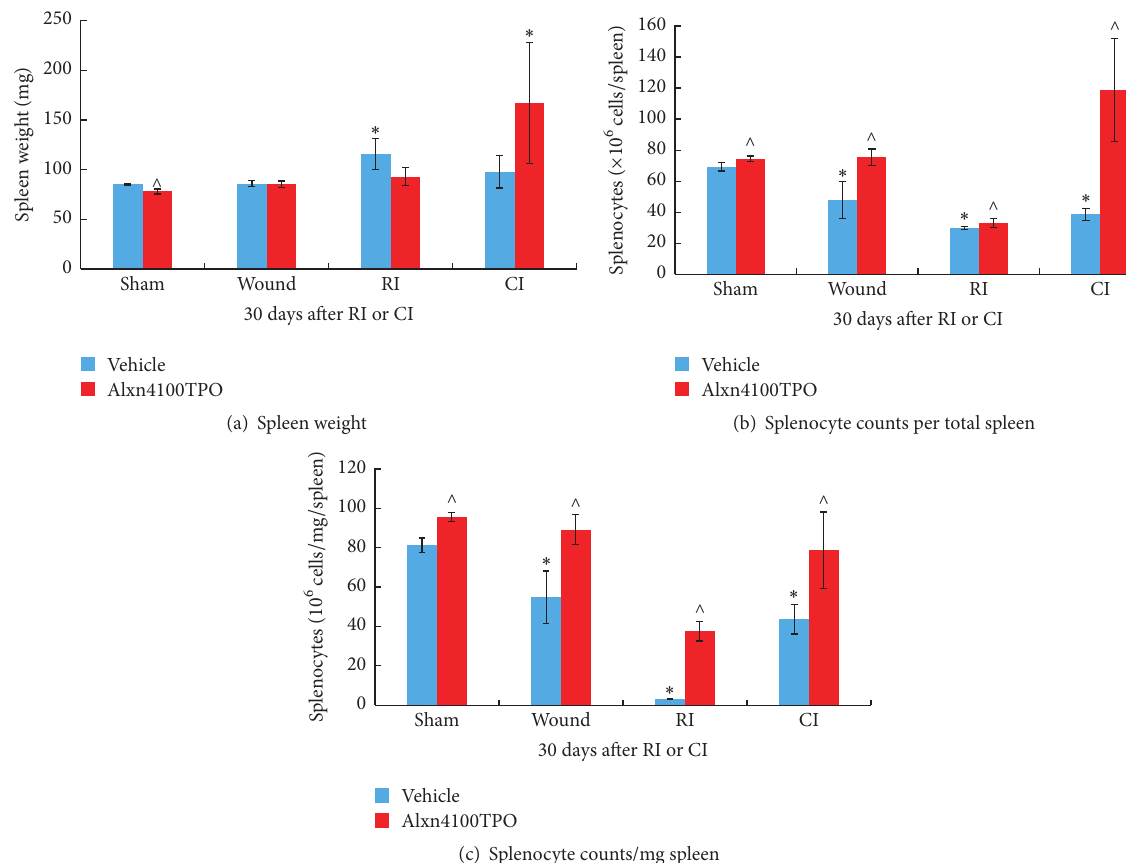
Figure 5: Different effects of Alxn4100TPO on spleen after RI or CI. (a) RI induced splenomegaly and Alxn4100TPO significantly mitigated splenomegaly but induced it after CI. (b) Wounding, RI, and CI decreased splenocyte numbers and Alxn4100TPO significantly increased them after sham, wounding, RI, and CI. (c) Each splenocyte count was normalized by its spleen weight. Spleens collected 30 days after RI and CI were weighed and then they were processed in a method to obtain resuspended cells. The numbers of splenocytes were counted. 𝑁 = 6 per group. Data are presented as mean ± SEM. ∗ 𝑝 < 0.05 versus Vehicle Sham; ∧ 𝑝 < 0.05 versus respective vehicle group. RI: 9.5 Gy; CI: 9.5 Gy and skin